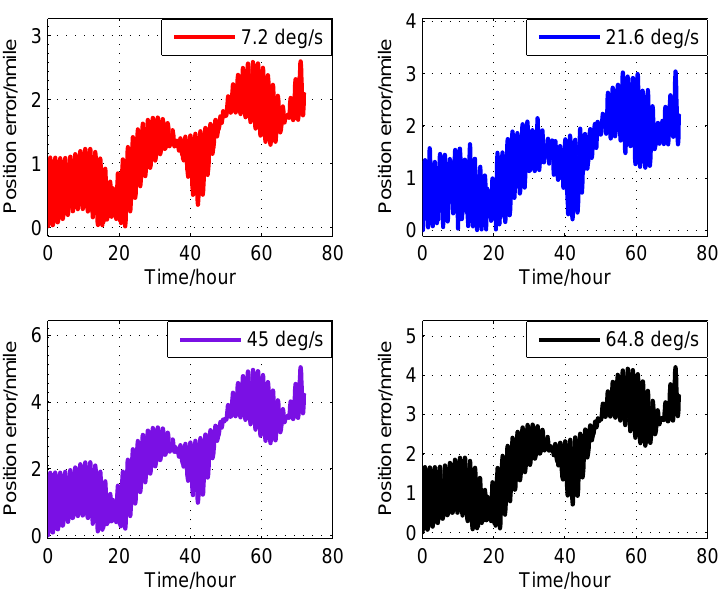
Figure 11. Simulation results of Group